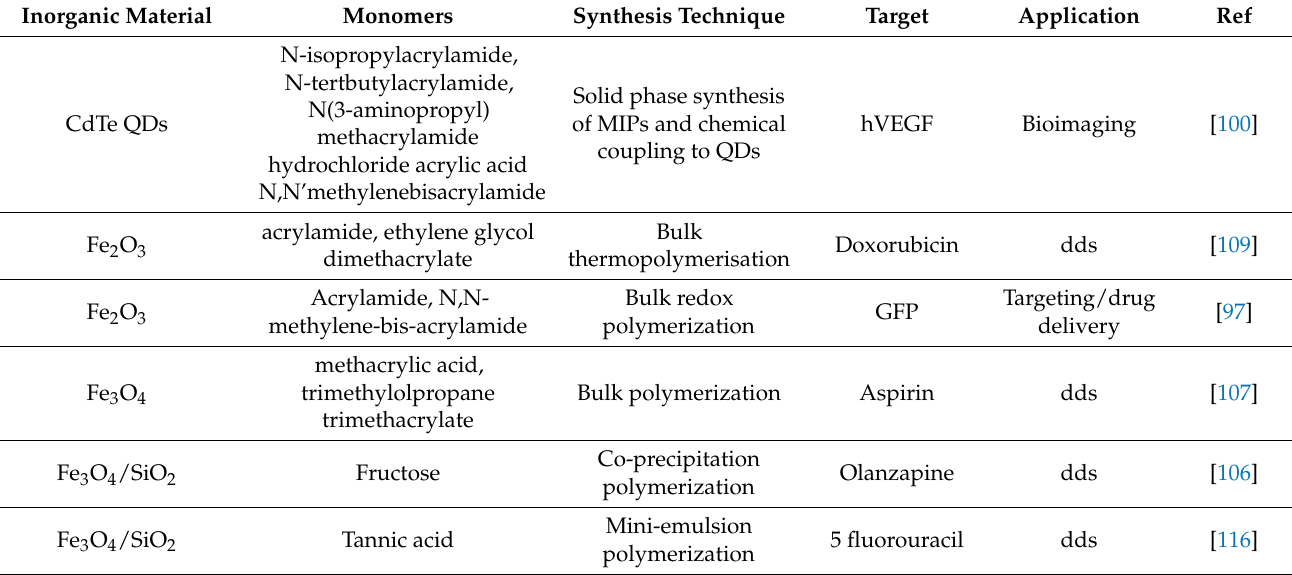
Table 1. Hybrid molecularly imprinted nanoparticles applied to nanomedicine. Inorganic Material